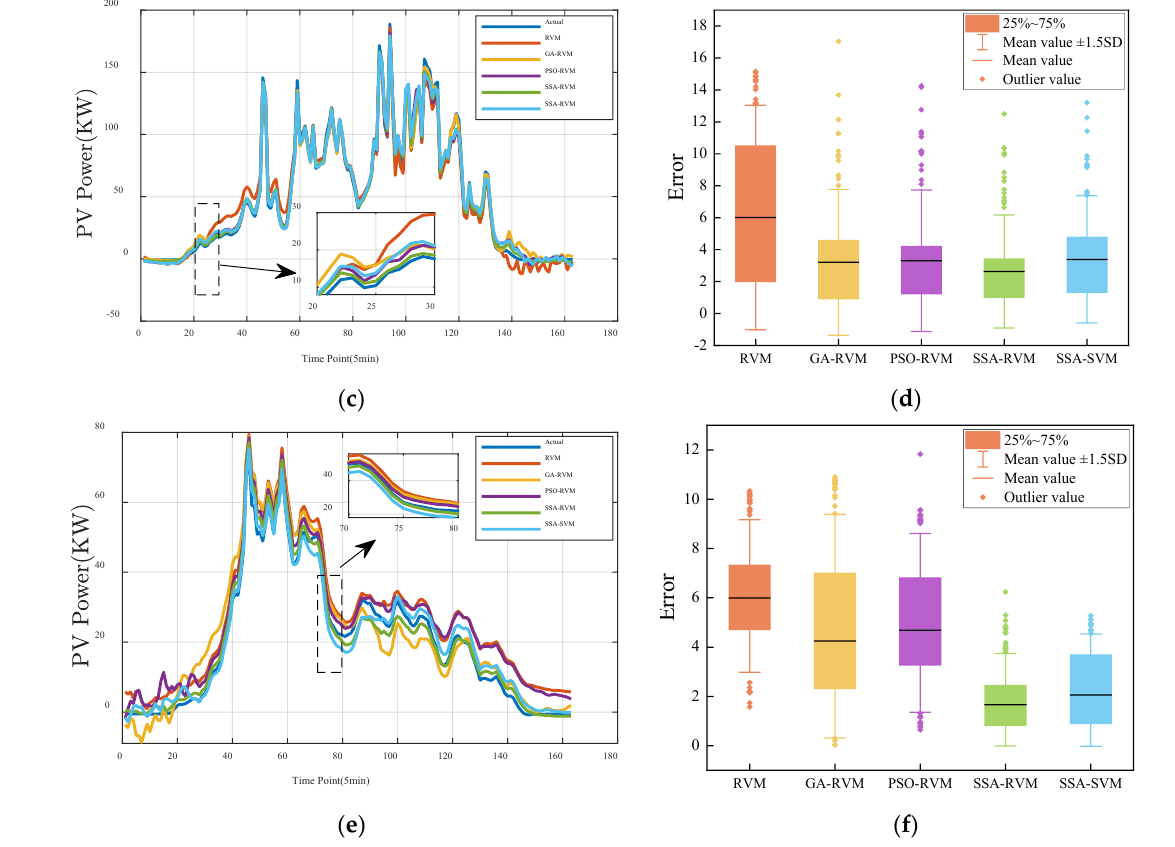
Figure 7. Results of different prediction methods under different weather types in autumn: PV power prediction results in ( a ) sunny, ( c ) cloudy and ( e ) rainy, forecasting error in ( b ) sunny, ( d ) cloudy, and ( f ) rainy.